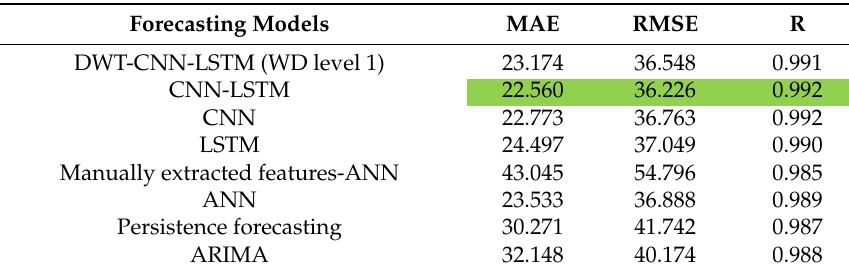
Table 8. The performance comparison of different sunny day’s forecasting models using the dataset of Elizabeth City State University.